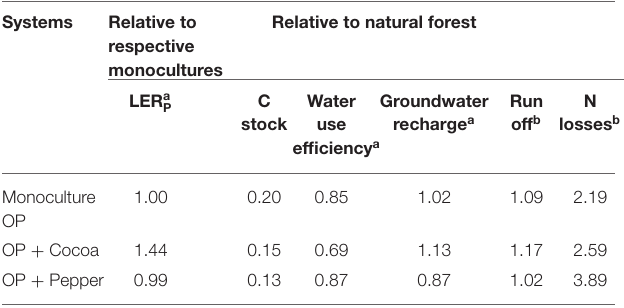
TABLE 6 | Land sparing as indicated by the provisioning services land equivalent ratio (LER P ) and land sharing as indicated by five regulating services with reference to forest conditions for each simulated